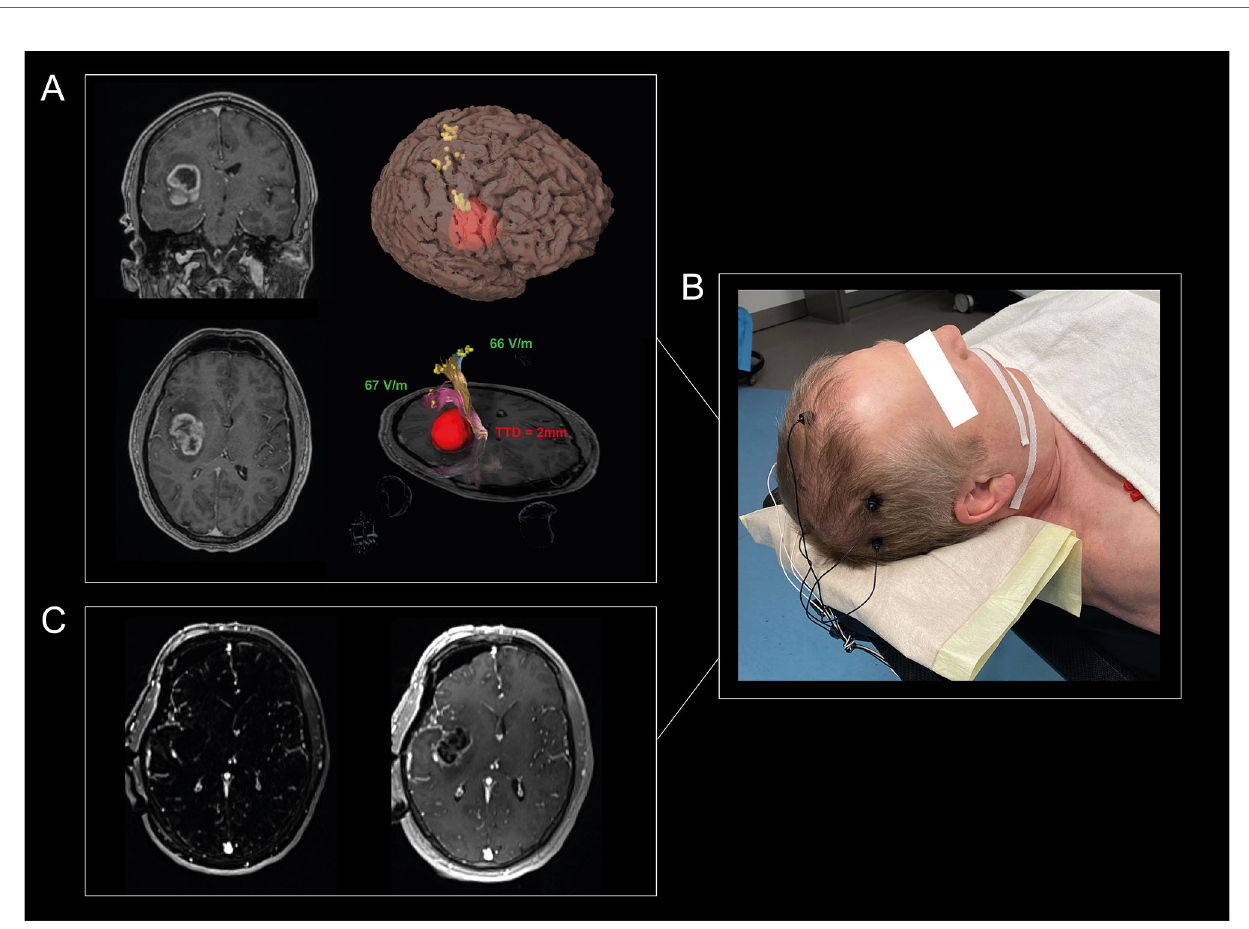
FIGURE 1 | Visualization of our work fl ow. A 65-year-old man suffered from headache and personality changes. Cerebral MRI showed an insular, contrast-enhancing tumor in the right hemisphere (A) . An nTMS motor mapping was performed for the upper extremity, lower extremity, and facial muscles to de fi ne the individual cortical motor representation and to investigate the individual excitability level of the patients, which showed a normal RMT ratio between 90% and 110%. Standardized nTMS-based tractography revealed a TTD of 2 mm, so that a total of 1 of 3 risk factors was detectable. Tumor resection was performed using MEPs, SSEPs, and SCS, with SCS guided by the mapping suction probe at a minimum intensity of 2mA. The MEPs showed changes two times, so resection was paused each time and irrigated with papaverine until the MEPs recovered (B) . MRI resection control showed a good result with no evidence of residual tumor (C) . The patient did not suffer a new motor de fi